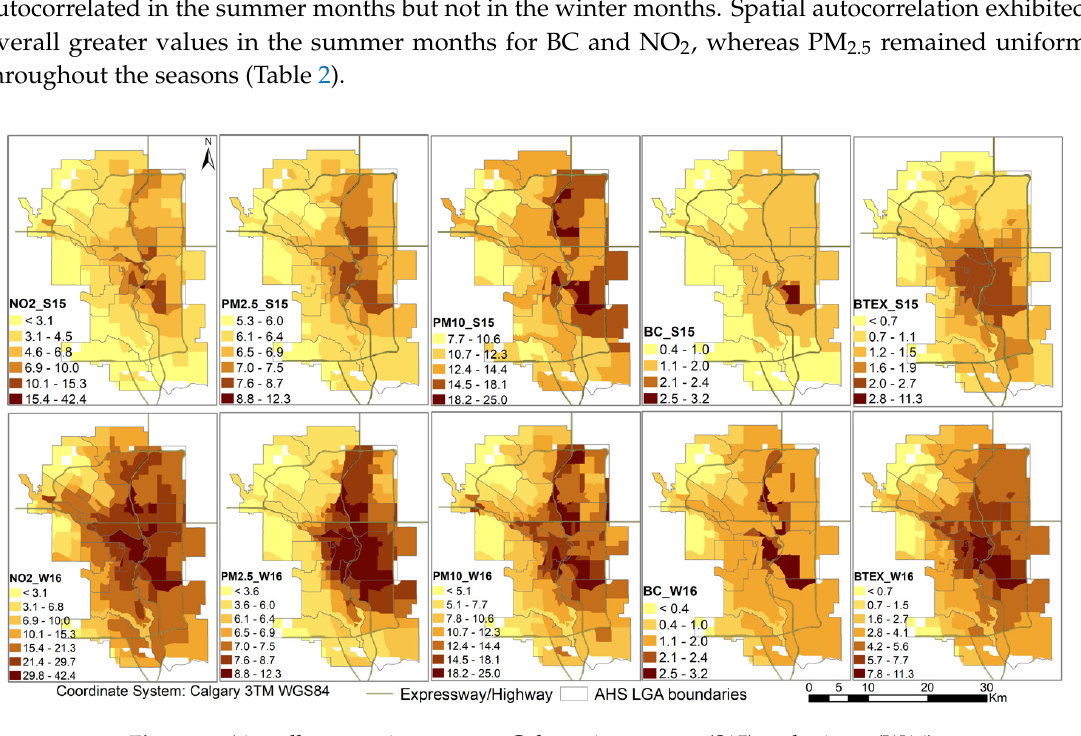
Figure 3. Air pollutant estimates over Calgary in summer (S15) and winter (W16).